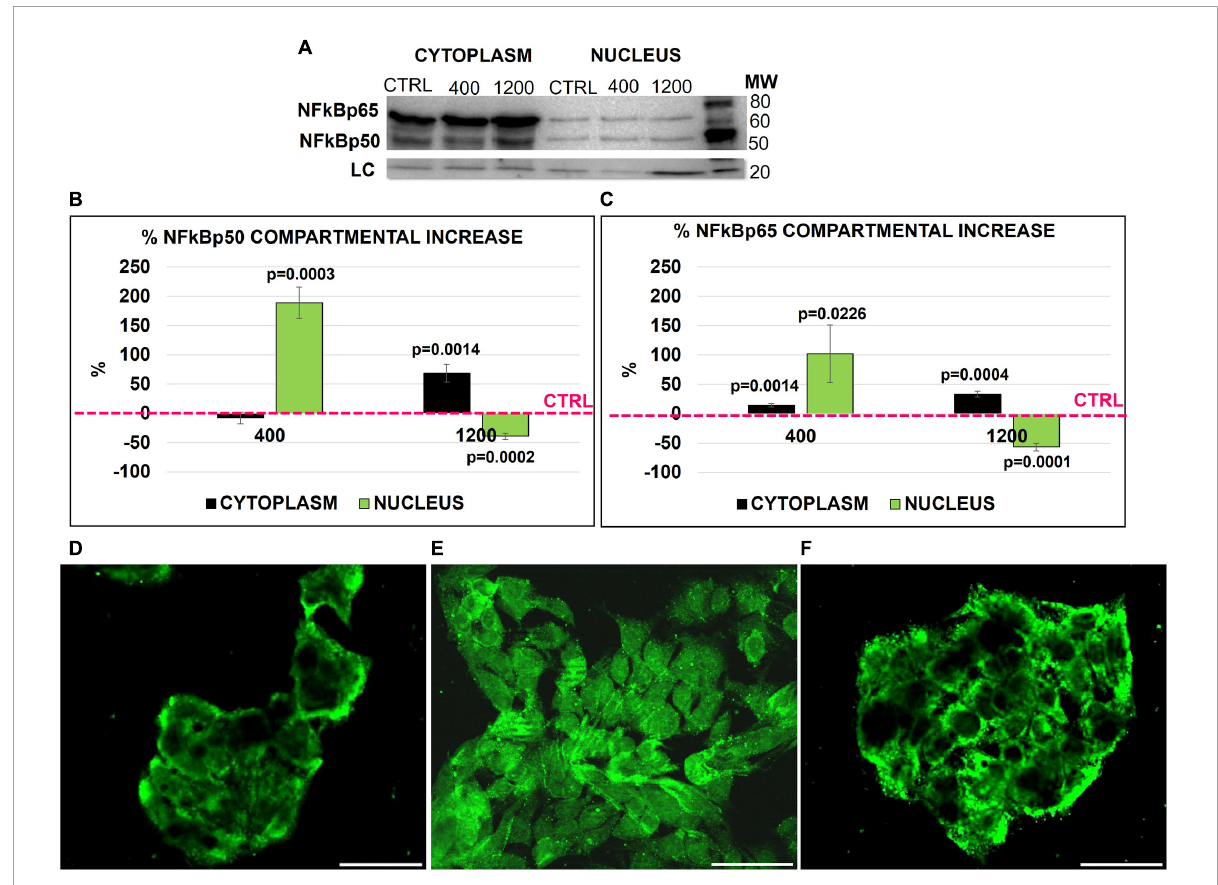
FIGURE2 NF κ B (p50 and p65) Western blot (WB) in the nucleus and cytoplasm of HepG2 in the ctrl and 24 h after adding 400 and 1,200 pg/ml of FGF23 (A) . NFKBp65/p50 compartmental protein quantification. Cytoplasm and nucleus % increase normalized by cofilin loading control and against the respective compartmental ctrl (B,C) . Immunostaining of NF κ B in the ctrl (D) and 24 h after the addition of 400 (E) and 1,200 pg/ml (F) of FGF23. N = 3 (B,C) , Scale bar 50 µ